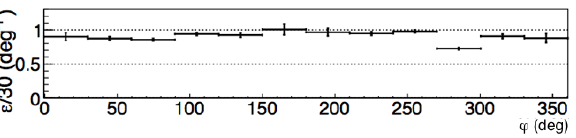
Figure 10. Inner Tracker e ffi ciency as a function of the ϕ − angle in the bending plane for one of the IT